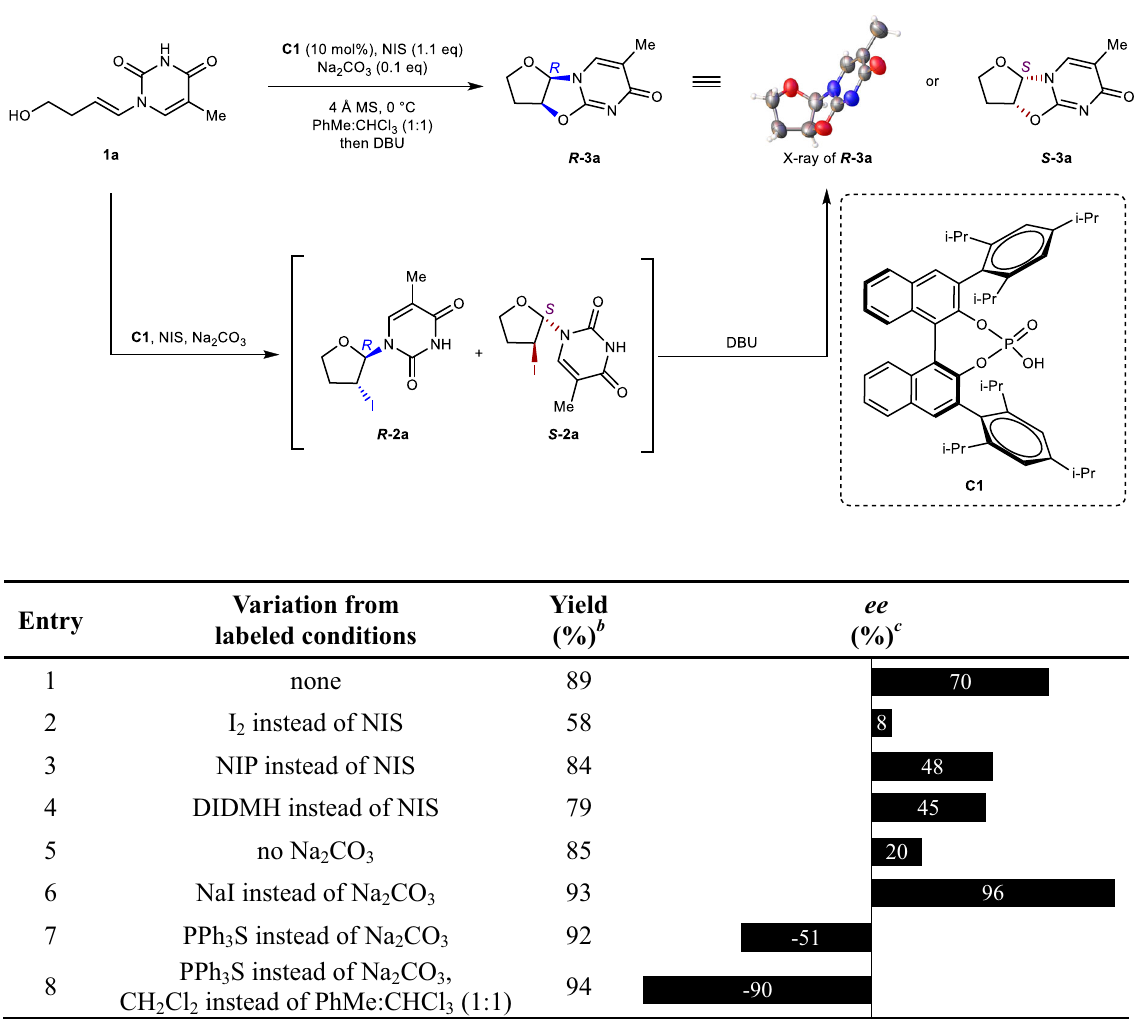
Table 1 | Reaction condition optimization